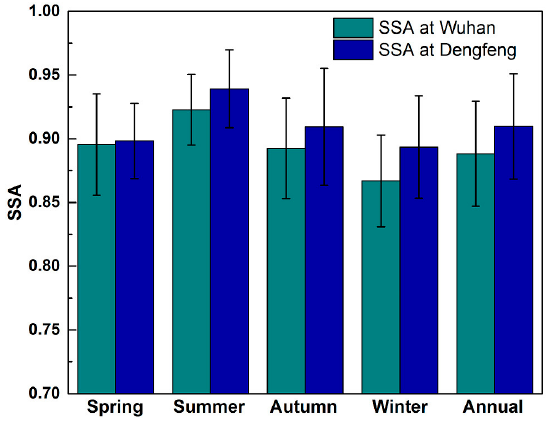
Figure 11. Annual and seasonal average single scattering albedo (SSA) in Wuhan and Dengfeng.